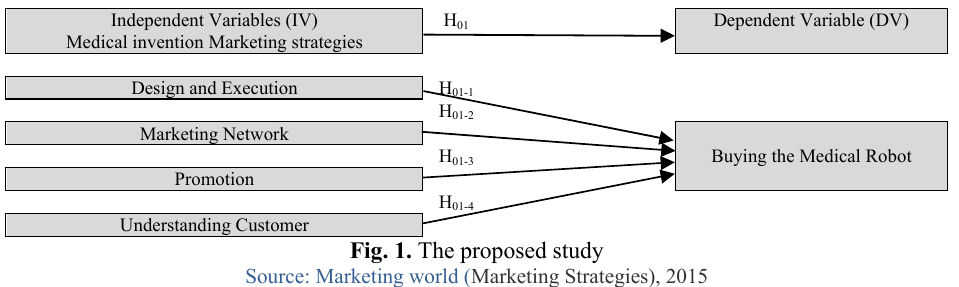
Fig. 1. The proposed